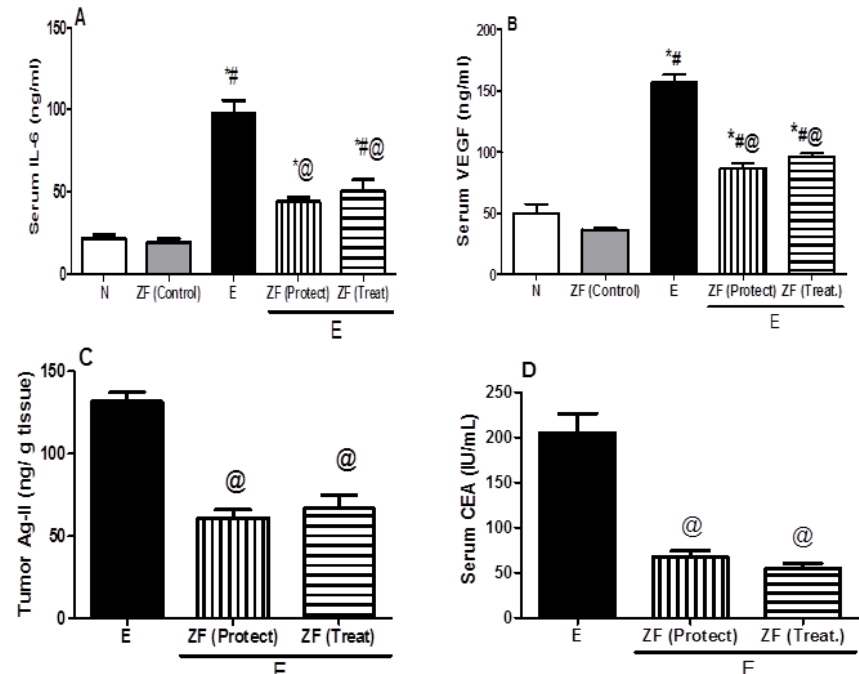
FIGURE 2 - Effect of ZF on serum levels of IL-6 and VEGF, as well as, Ag-II and CEA tumor